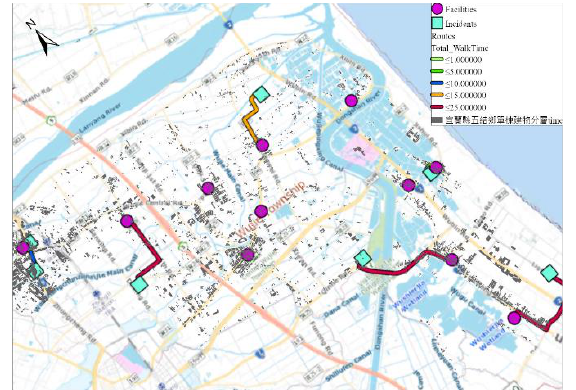
Figure 13. Visualization of capacity simulation